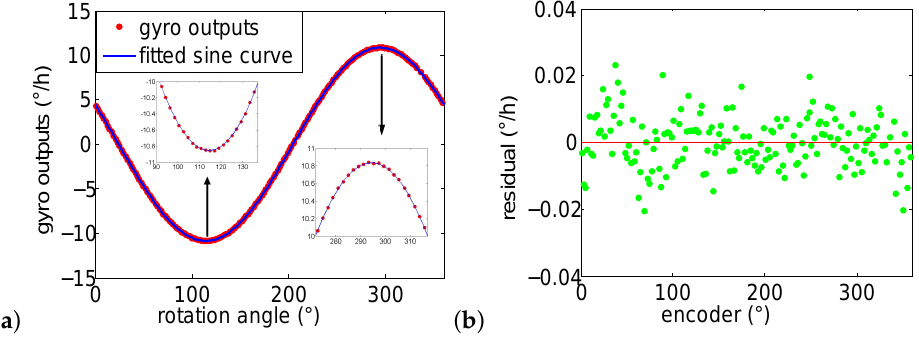
Figure 14. Gyro outputs fitting results when the number of measurement points n = 180. ( a ) Fitting curve when n = 180; ( b ) Residual of the corresponding fitting